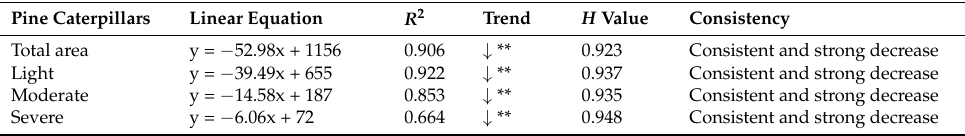
Table 3. Trend, Hurst ( H ) values, and consistency of pine caterpillars in Shandong Province. Pine Caterpillars Linear